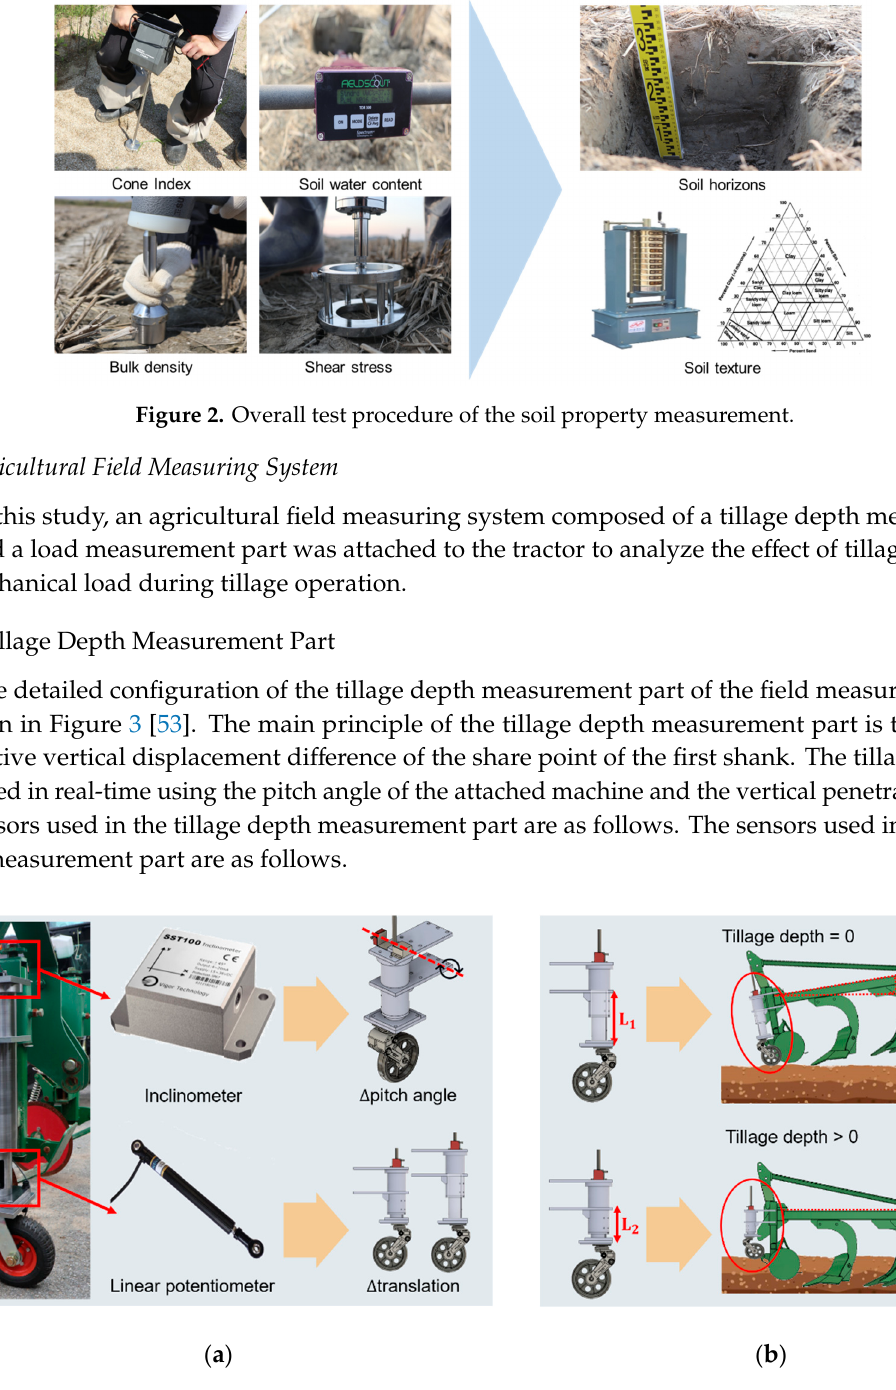
Figure 3. Tillage depth measurement part of the agricultural field measuring system: ( a ) configuration of measurement system and ( b ) principle during tillage operation.